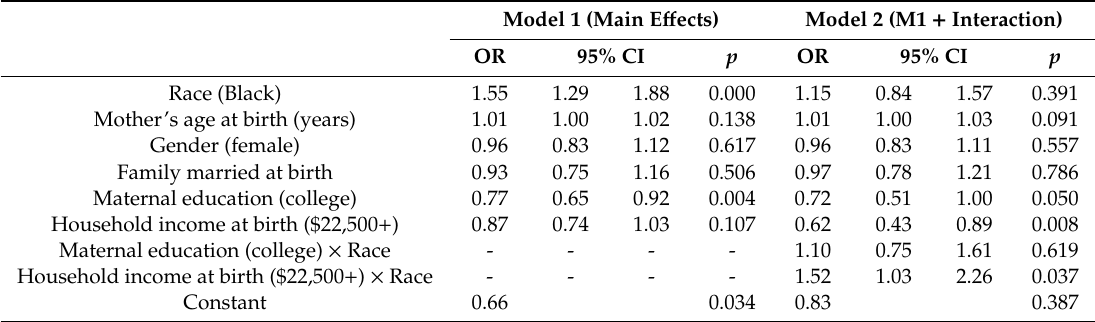
Table 2. Linear regression models with gang presence in the neighborhood at age 15 as the outcome in the overall